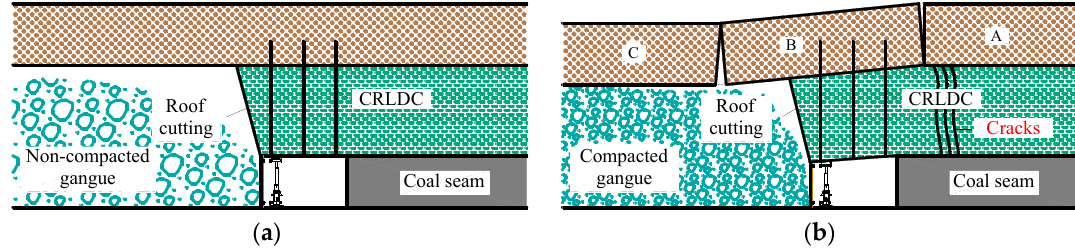
Figure 9. Roof structure and motion state when the roof-cutting height is insufficient. ( a ) Initial state; ( b ) Terminal state.